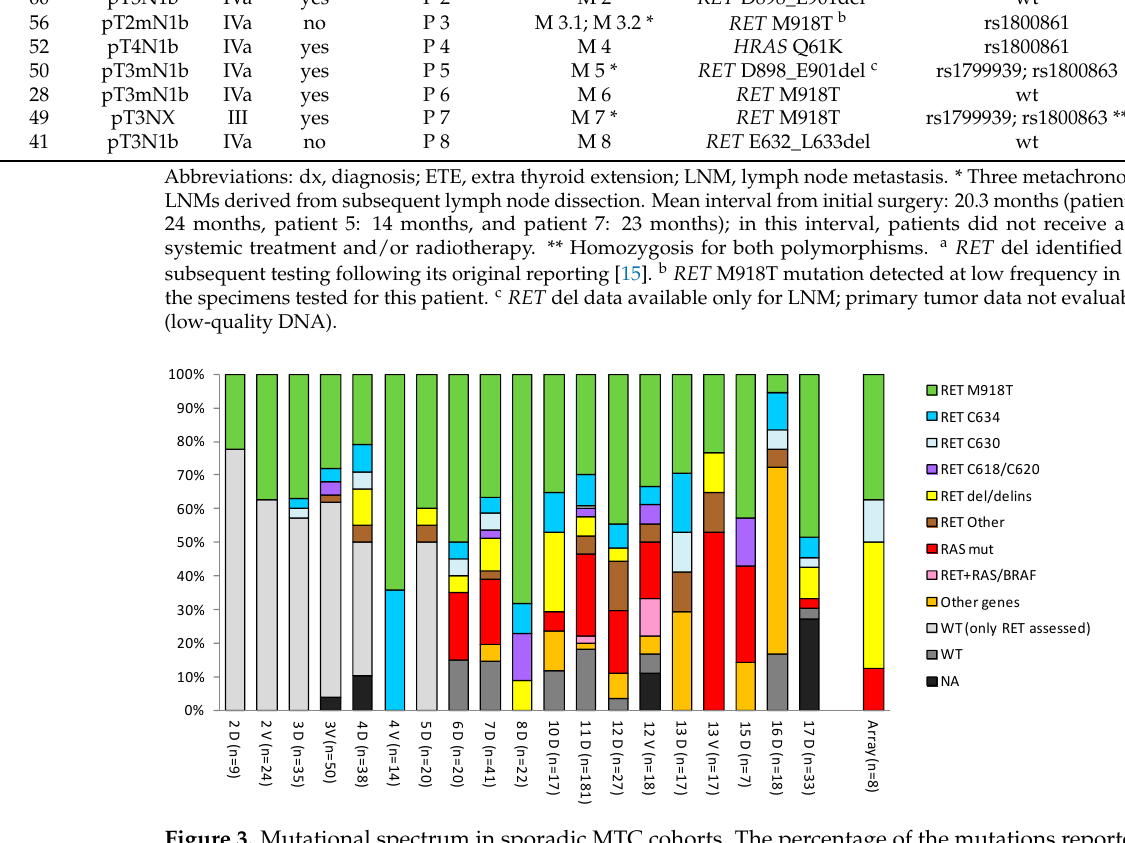
Figure 3. Mutational spectrum in sporadic MTC cohorts. The percentage of the mutations reported in each MTC sporadic cohort is shown; cohorts are identified by the corresponding study ID (see Table 1) and the discovery (D) or validation (V) set type. The number of samples ( n ) in each cohort is in parentheses. The “Array” bar represents the eight patients described in Table 2 selected from a larger cohort (study 17). The RET Other class includes both mutations in less frequent codons and multiple co-occurring RET mutations.